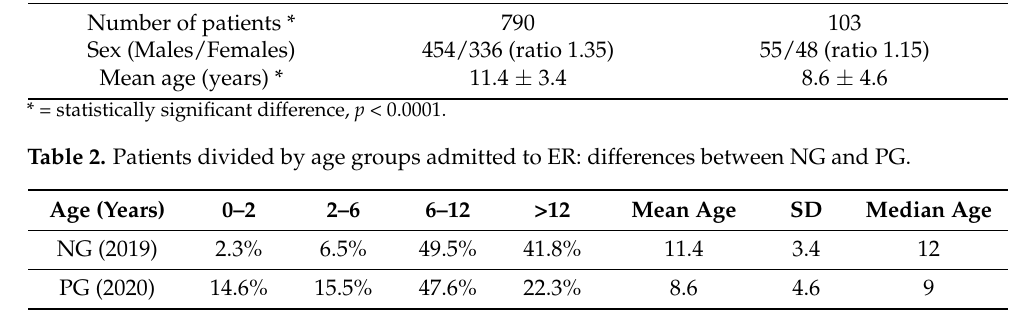
Table 2. Patients divided by age groups admitted to ER: differences between NG and PG.